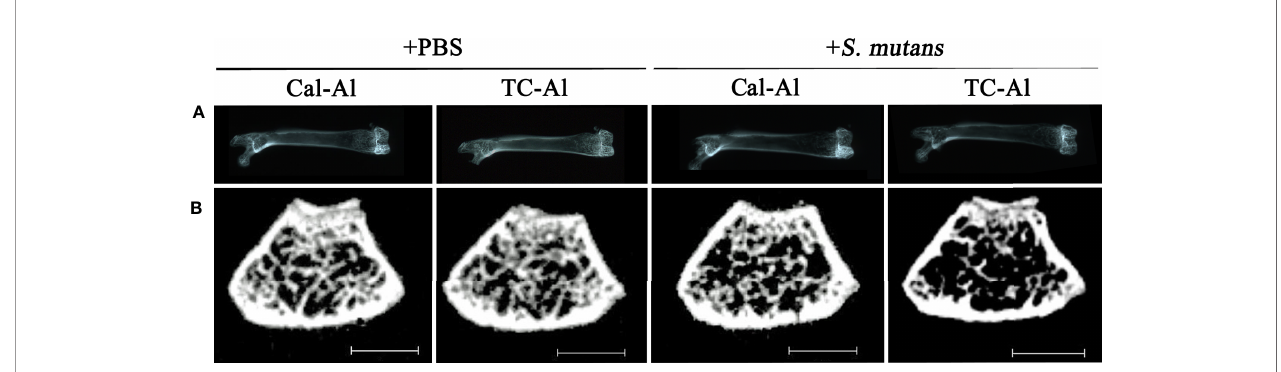
FIGURE 4 | Representative radiological examination of the femur. Radiological analyses of the femurs after seven days of intravenous injections of PBS or S. mutans inoculation. (A) Representative soft X-ray photographic images of femurs. (B) Representative µCT images of a cross-section at the diaphysis of the distal end of the femurs. Cal-Al, mice received double injections of calcein and alizarin; TC-Al, mice received double injections of tetracycline and alizarin; +PBS, intravenously PBS- injected groups; +S. mutans , intravenously S. mutans -inoculated groups. Scale bar =